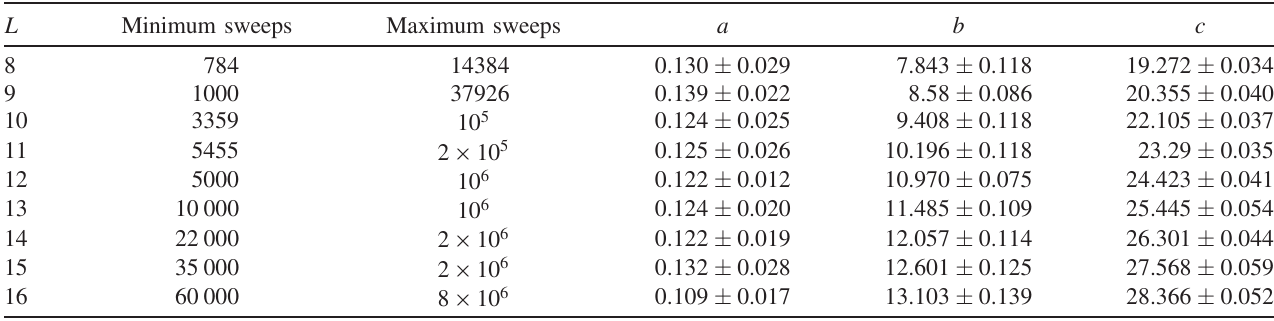
TABLE XI. Fit to y ¼ a ð x − b Þ 2 þ c for the median results of the logical-planted instances using SA with y ¼ log TTS and x ¼ log n . The factor c does not include f sweeps